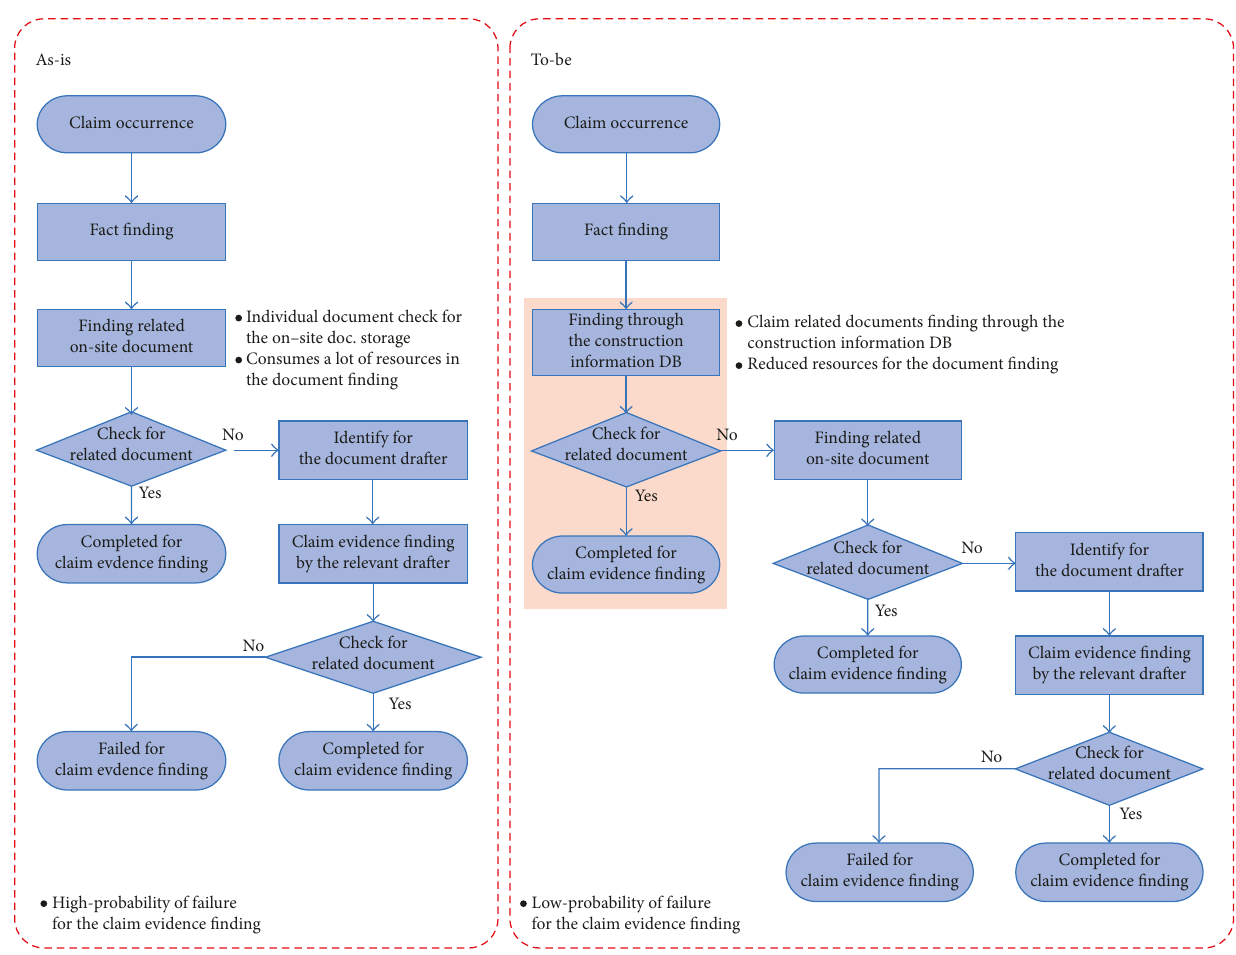
Figure 11: Comparison of claim materials’ collection